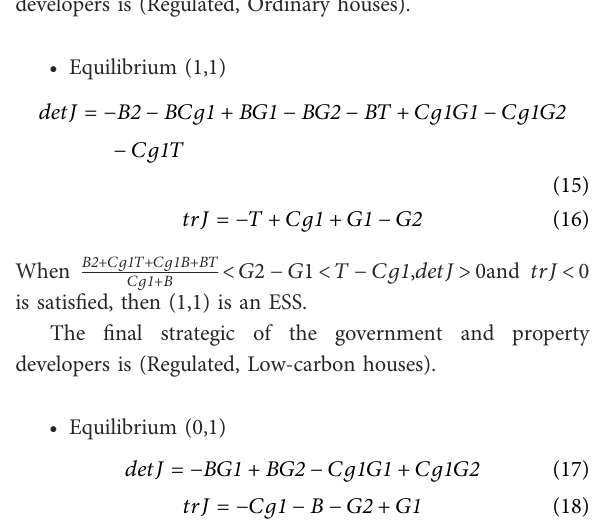
The fi nal strategic of the government and property